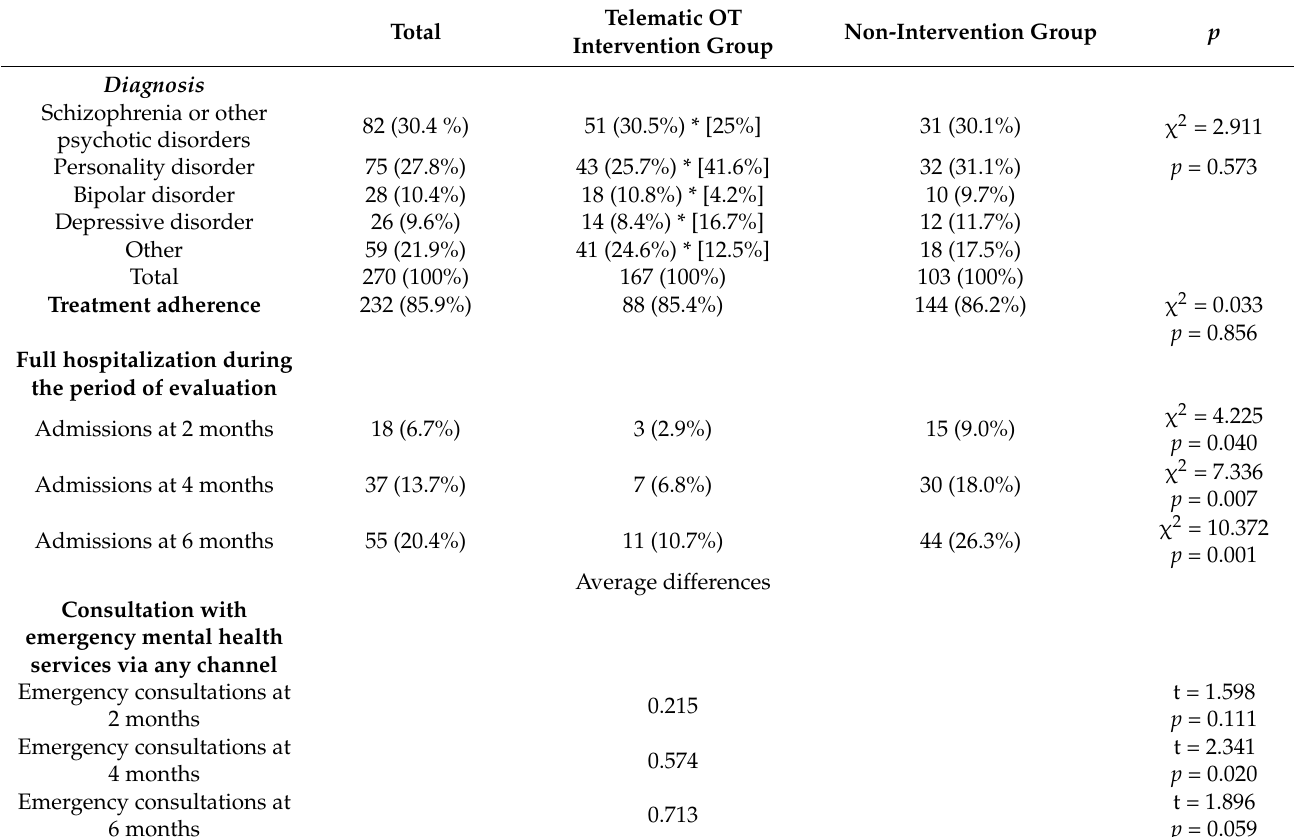
Table 3. Clinical characteristics of the group that received occupational therapy.